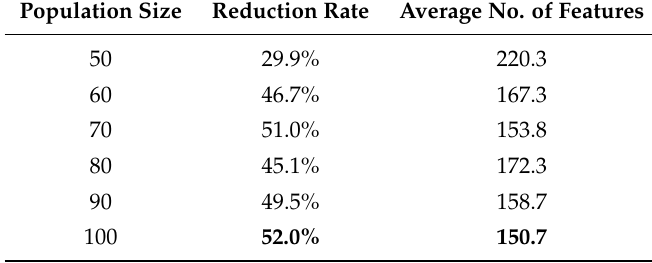
Table 4. The influence of several population sizes of the SSA algorithm in terms of reduction rate and average number of